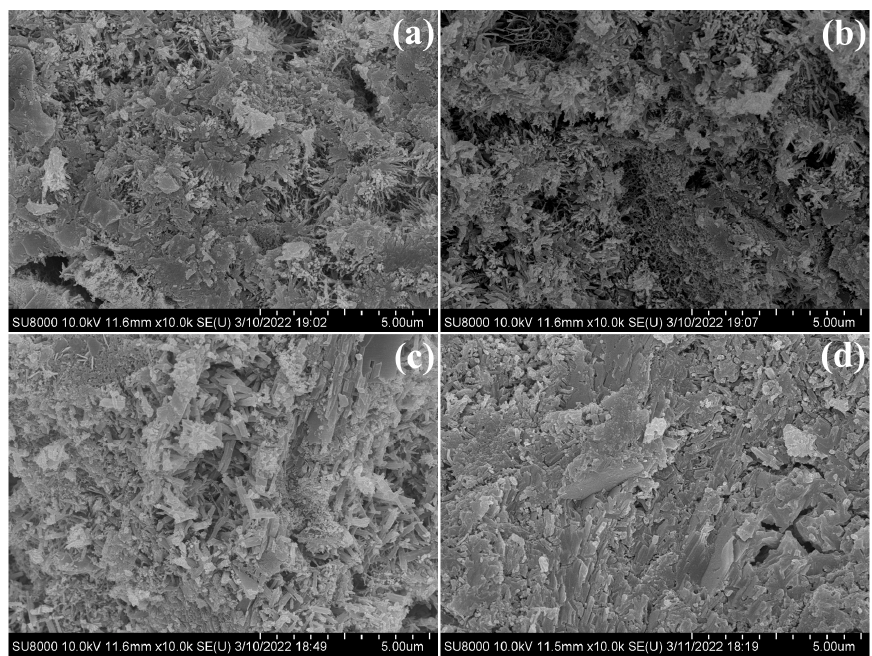
Figure 13. Morphology of different binders after curing 10 h, ( a ) PC; ( b ) PC-2.0 wt%; ( c ) PC-CSA; ( d ) PC-CSA-2.0 wt%.